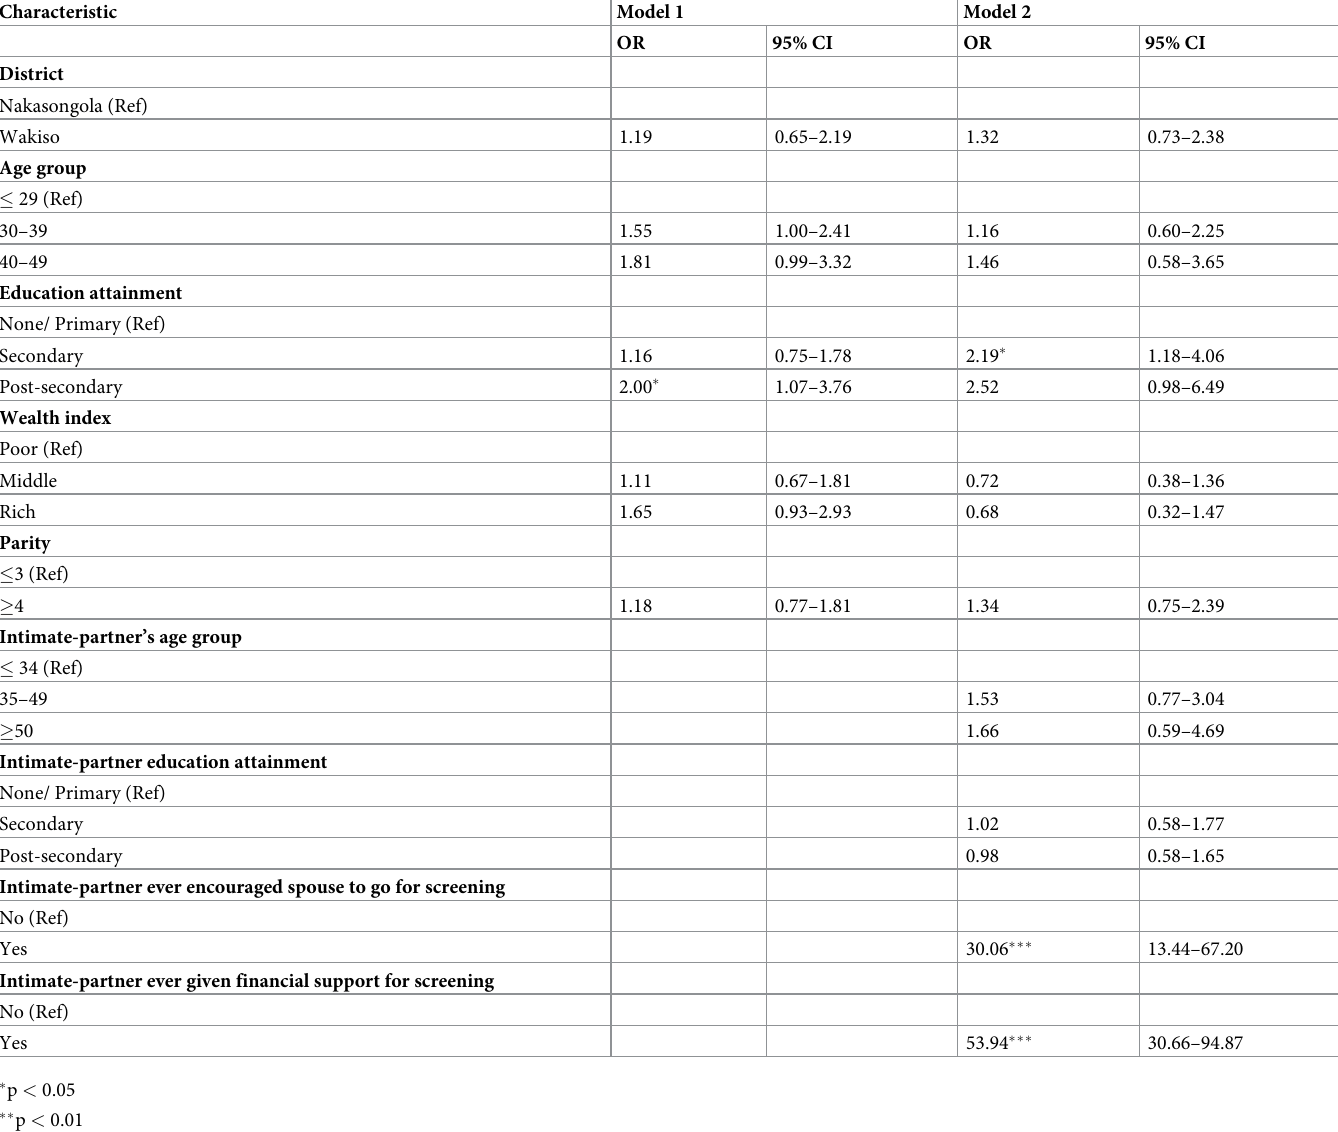
Table 2. Associations between socio-demographic, economic and male partner factors with cervical cancer screening.